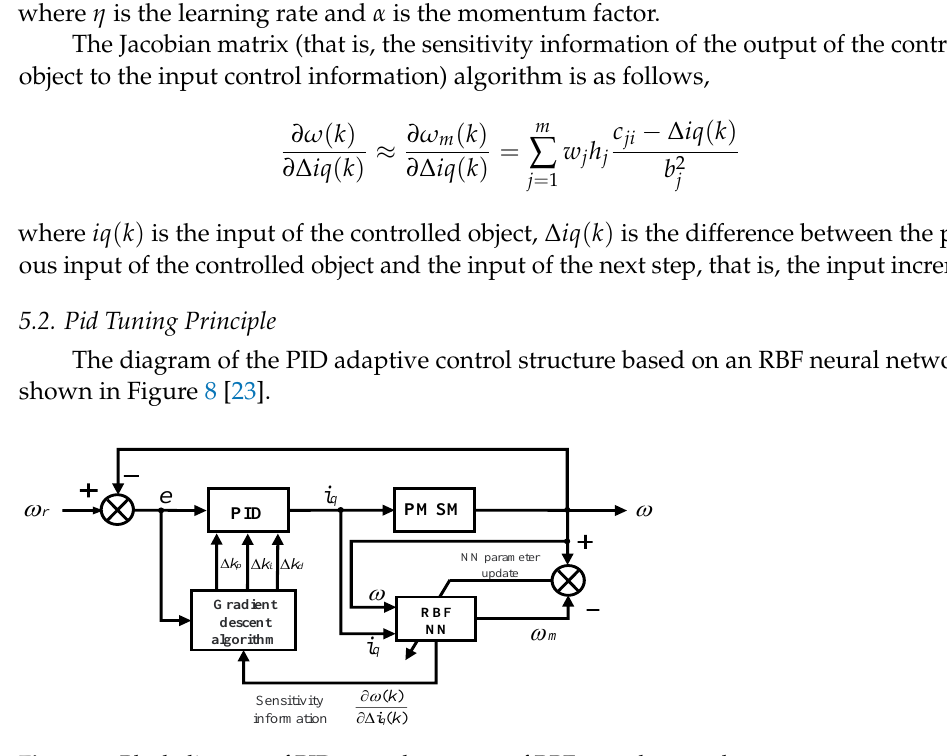
Figure 8. Block diagram of PID control structure of RBF neural